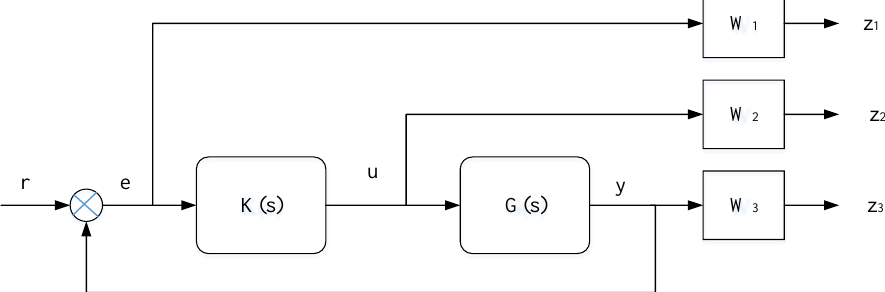
Figure 11. Mixed sensitivity problem with weighting functions ( 𝑊 1 , 𝑊 2 , 𝑊 3 are the weighting functions).